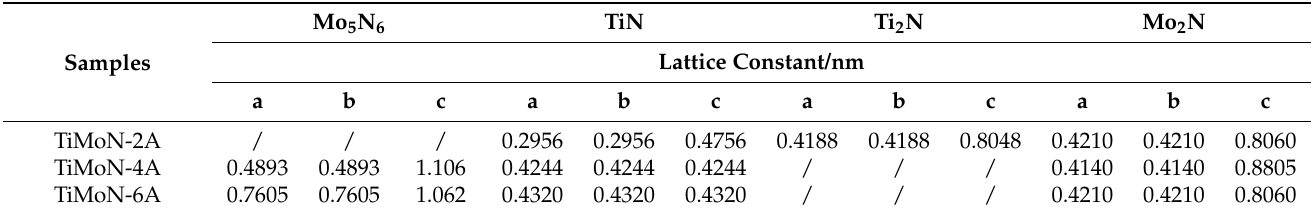
Figure 2. XRD pattern of SS316L and TiMoN coatings: ( a ) full spectrum, ( b ) partial spectrum. Table 3. Lattice constants of the main diffraction